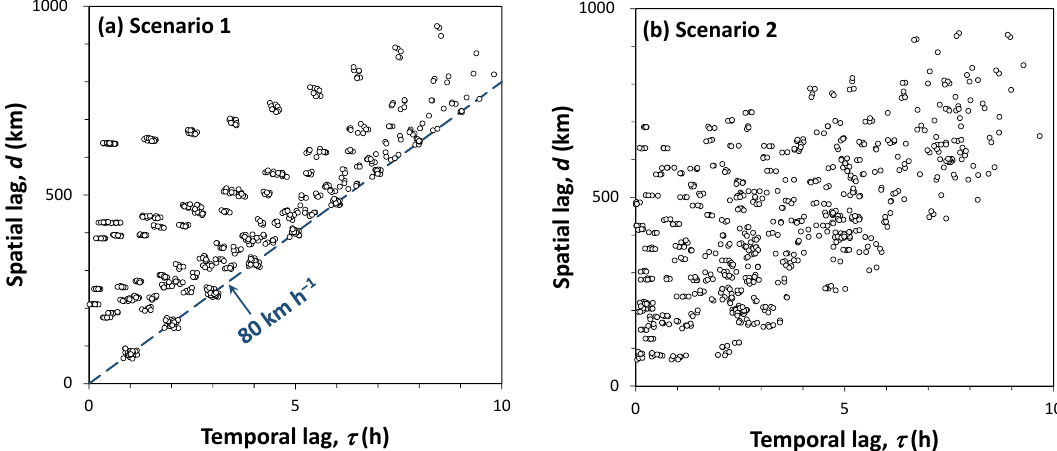
Figure 9. Spatial–temporal lag diagrams for the two model scenarios given in Fig.